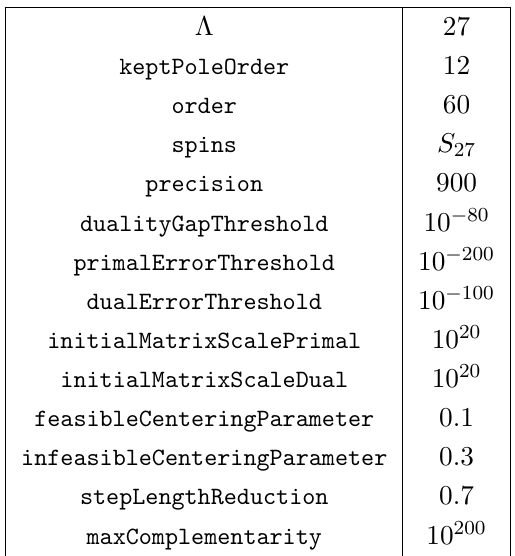
Table 6 . Parameters for the computations in section 4.4. The set S 27 is de(cid:12)ned in